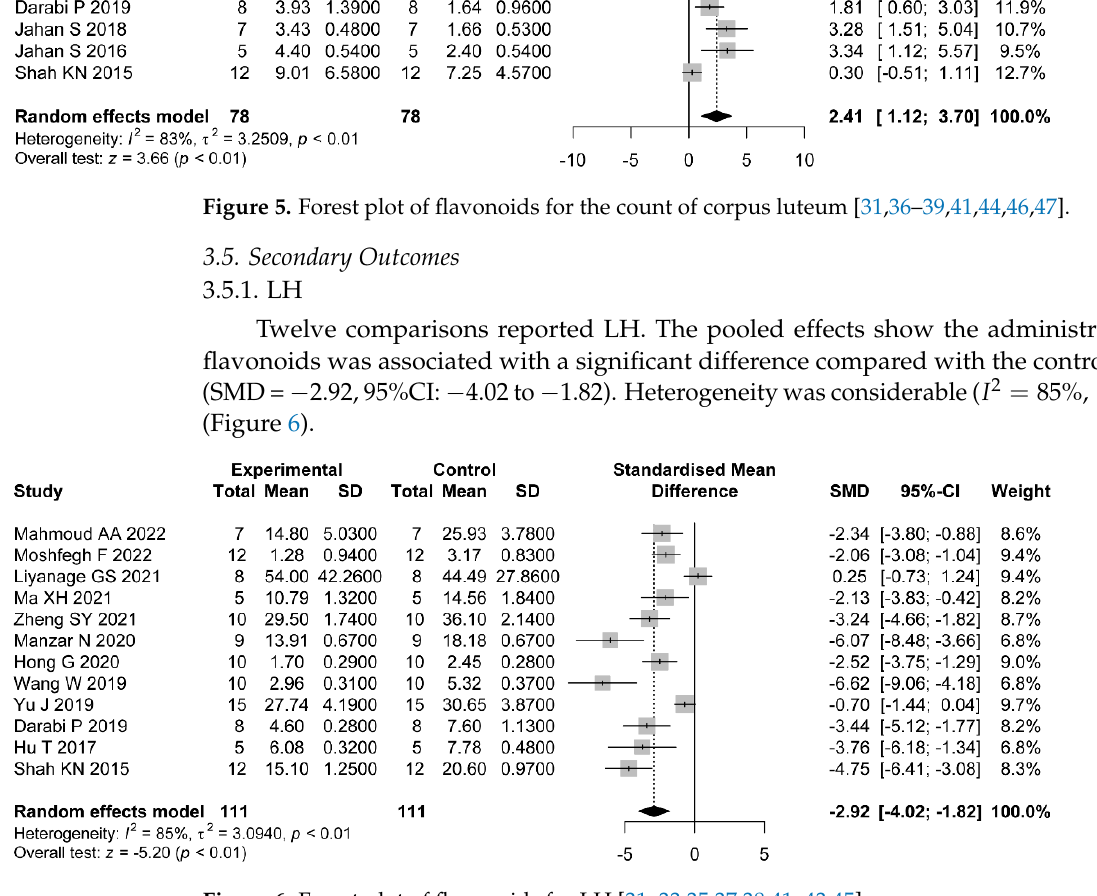
Figure 6. Forest plot of flavonoids for LH.